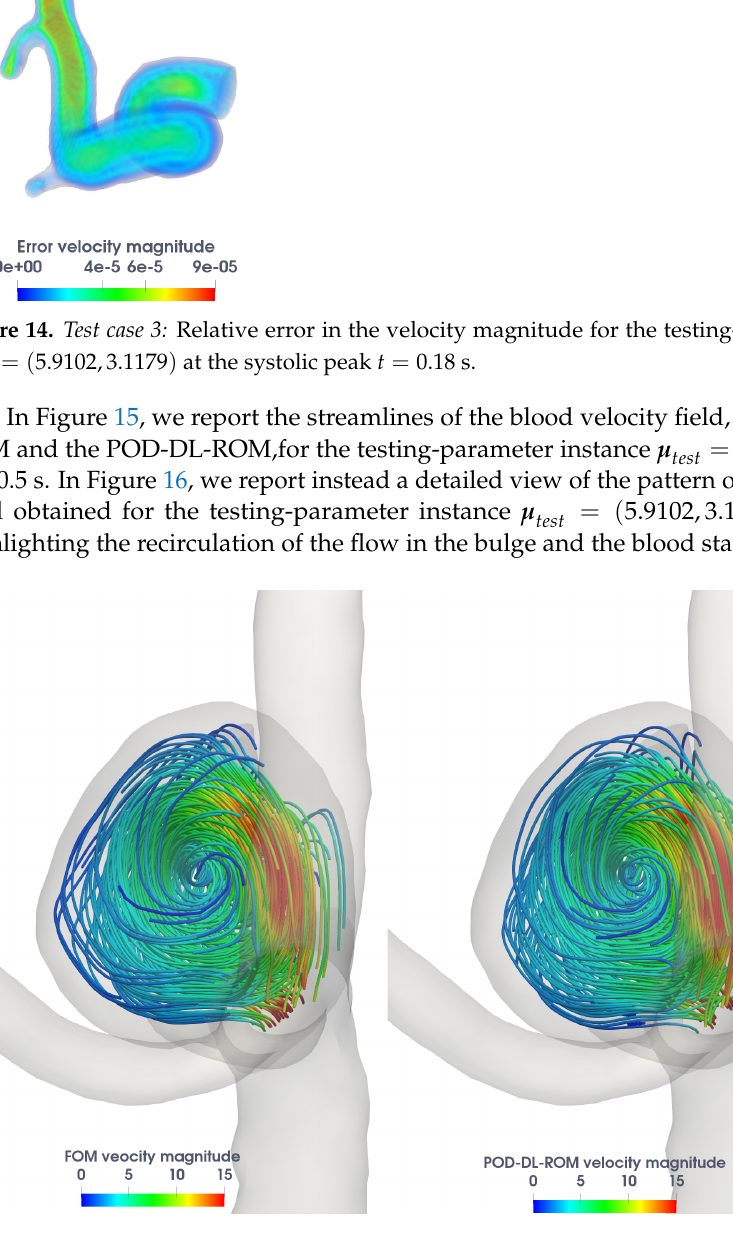
Figure 15. Test case 3: FOM ( left ) and POD-DL-ROM ( right ) velocity magnitude streamlines for the = ( 5.9102,3.1179 ) at the systolic peak t = 0.5 testing-parameter instance µ test